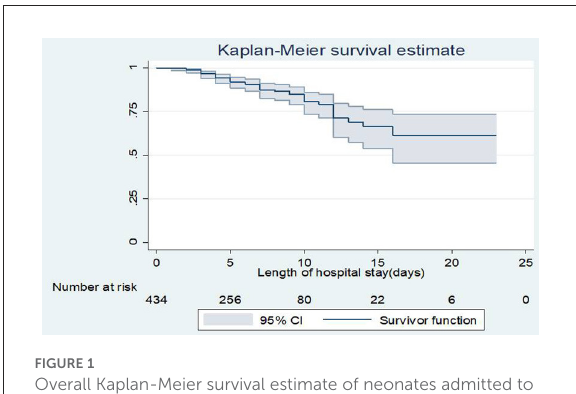
FIGURE1 Overall Kaplan-Meier survival estimate of neonates admitted to NICU, TASH, Addis Ababa, Ethiopia, from 1 January 2015 – 30 December